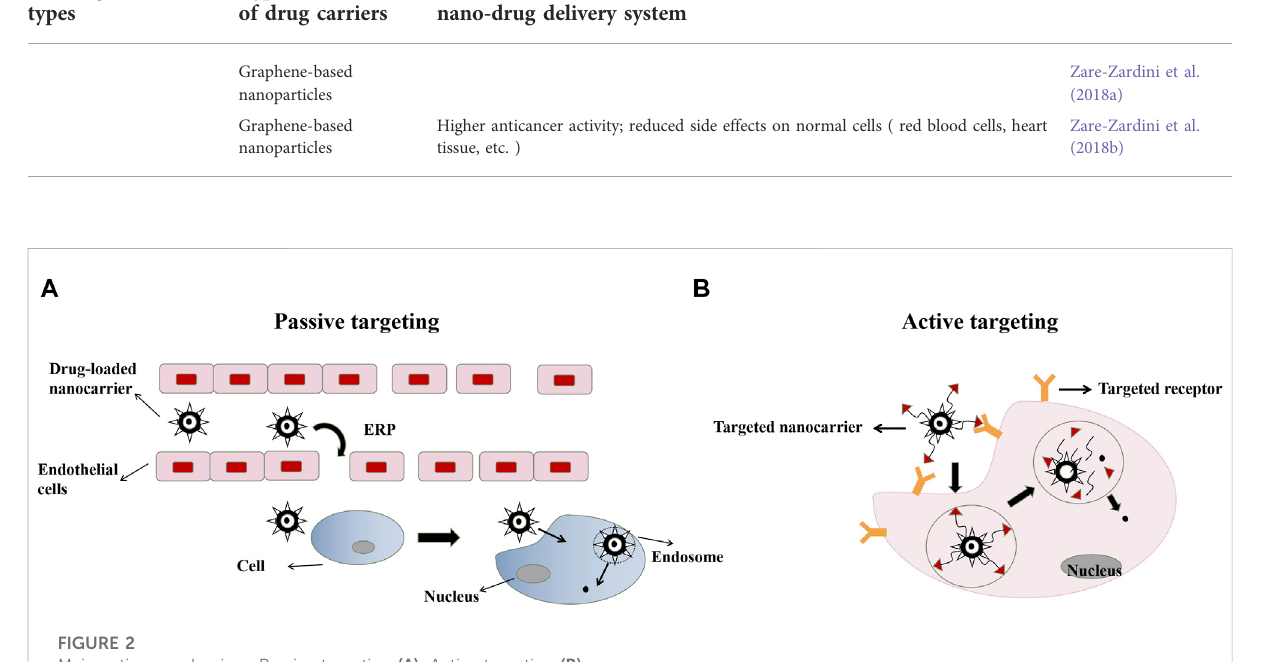
FIGURE 2 Main action mechanism: Passive targeting (A) ; Active targeting (B)